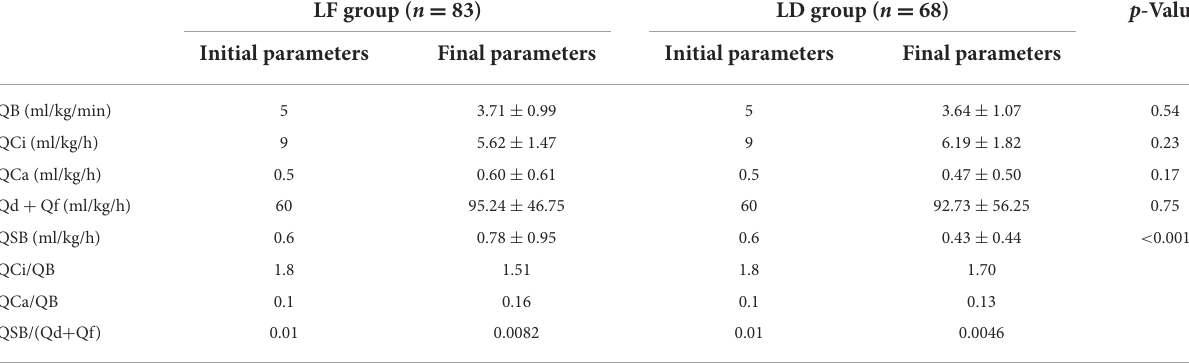
TABLE 4 Comparison of RCA-CRRT parameters at the beginning and end of the LD and LF